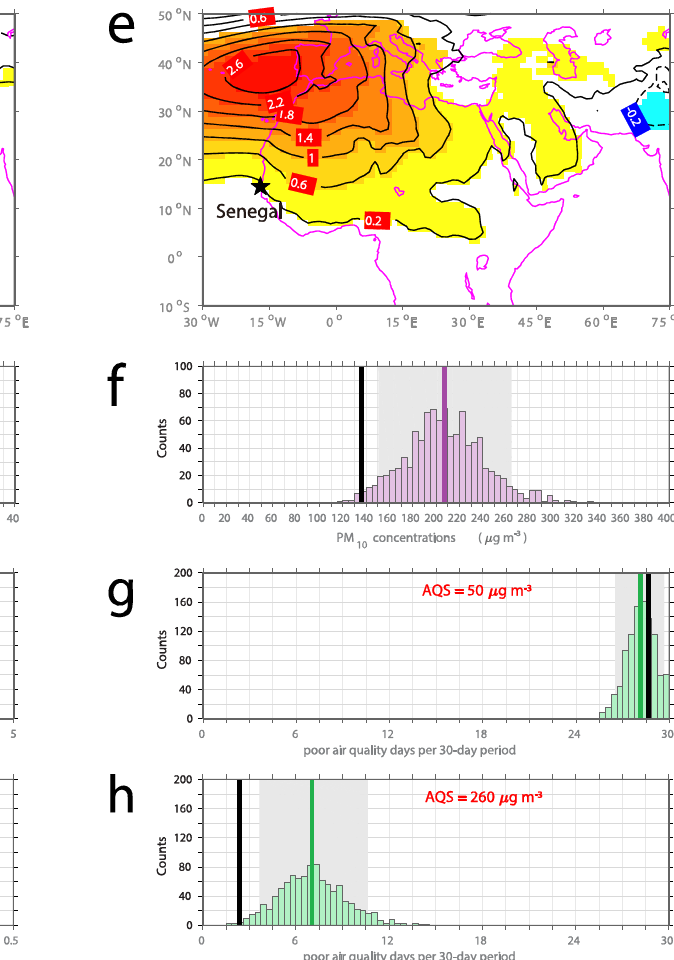
(AQS), during 1000 sets of non-SSW episodes (colored bars, see Methods). Thick vertical colored line indicates the non-SSW mean; gray shading indicates the 5th – 95th percentile con fi dence interval derived from the non-SSW spread. Thick verticalblacklineindicatestheSSWcomposite.Inpanels c , d ,poorairqualitydays are de fi ned when the daily-mean PM 10 concentrations exceed the daily limit of c 50 μ gm − 3 and d 260 μ gm − 3 , respectively. e – h The same as a – d but for station observations of surface PM 10 concentrations from M'Bour, Senegal. Made with Natural Earth. Free vector and raster map data @